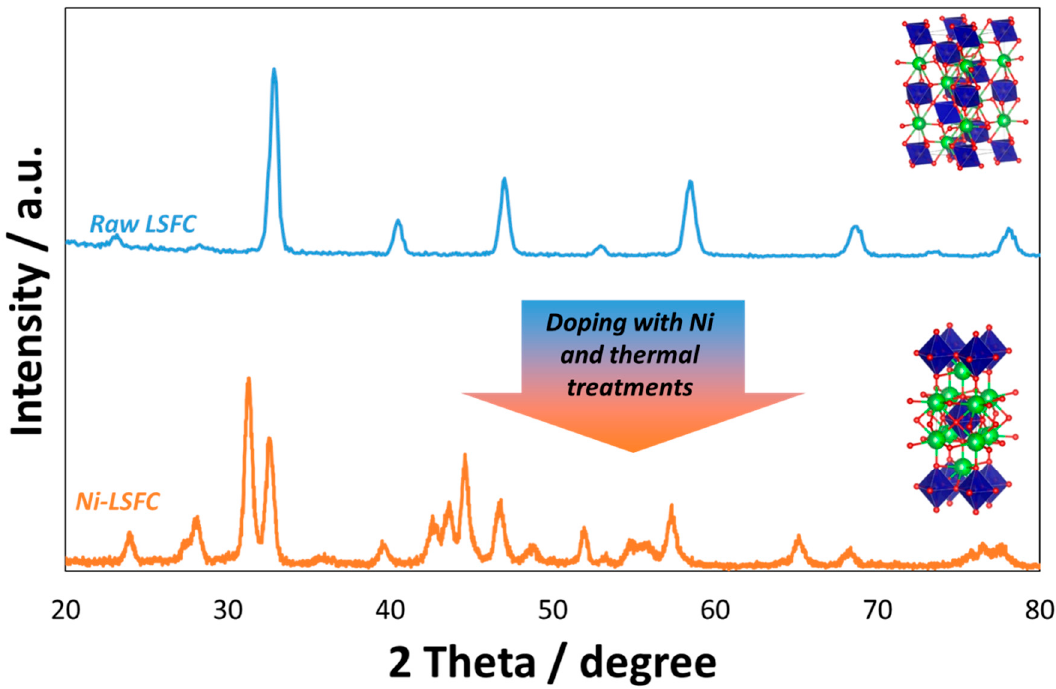
Figure 1. Structural analysis of raw (top) and modified (bottom) perovskites. The figure also reports the related unit cells. As shown, the addition of Ni and subsequent thermal treatments (calcination at 500 °C and reduction at 800 °C) caused the intercalation of one rocksalt-type phase into the perovskite (n = 1 Ruddlesden–Popper phase).